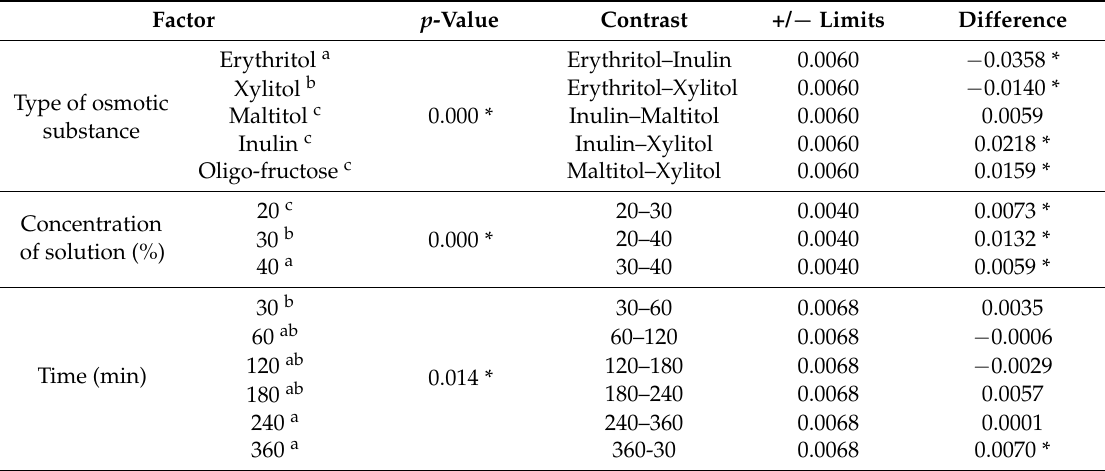
Table 8. The influence of osmotic pre-treatment in different types, concentrations of solutions, and time on a w during